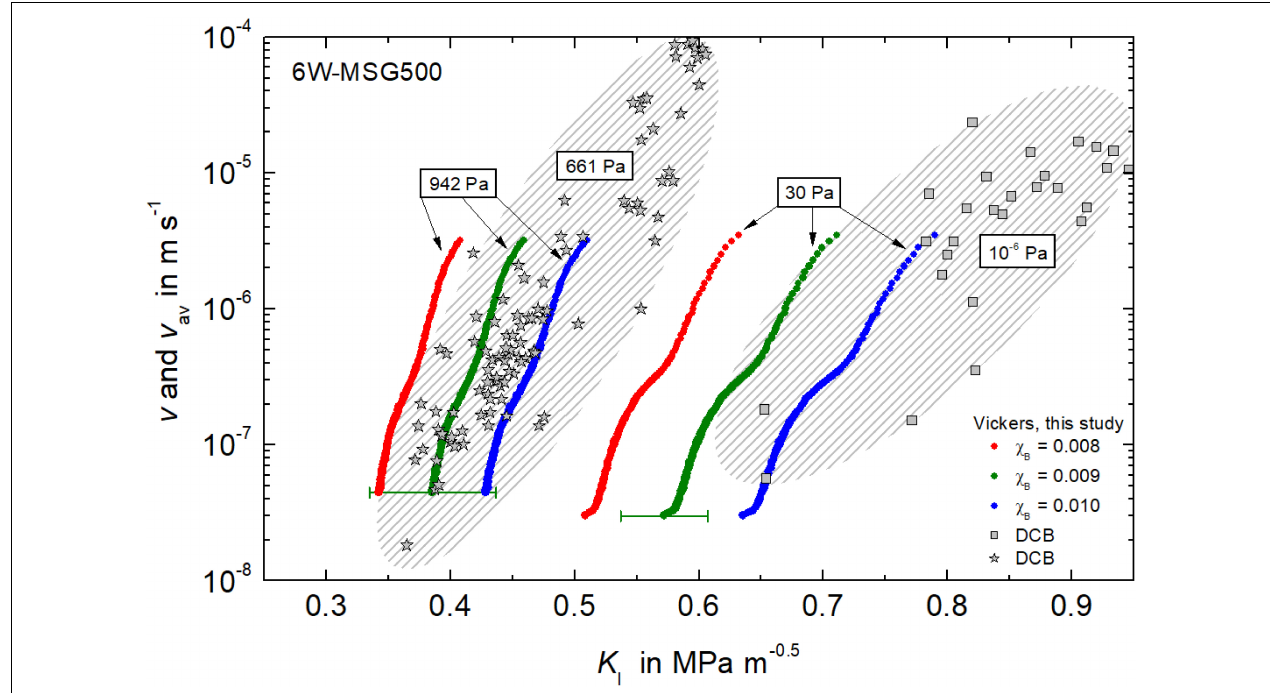
FIGURE 8 | Mean crack propagation rate v av ( N = 259 and 370) and crack propagation rates v of single cracks (stress calibrated DCB specimens) of the hydrous glass 6W-MSG500. Stress intensities K I of the Vickers induced v av data of this study are shown for χ B = 0.008 (red dots), 0.009 (green dots) and 0.010 (blue dots). Partial pressure of H 2 O as indicated. DCB data from Waurischk et al. (2020). Error bars show standard deviation of the crack length distributions of Table 2